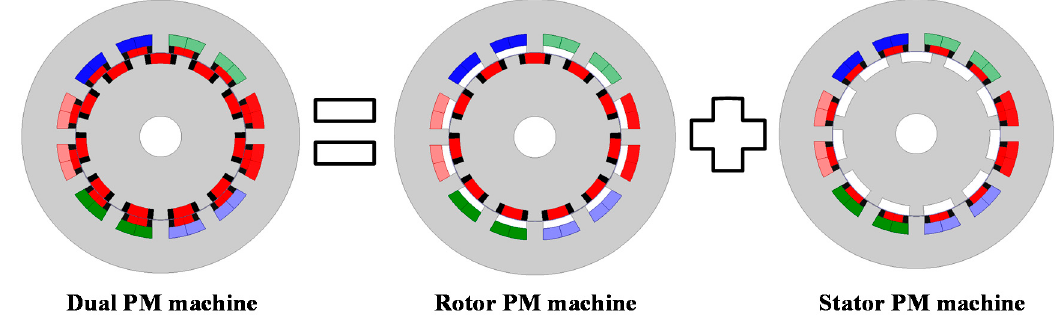
Figure 2. Machine decomposition of 12S11R1Pa SSDPM machine.